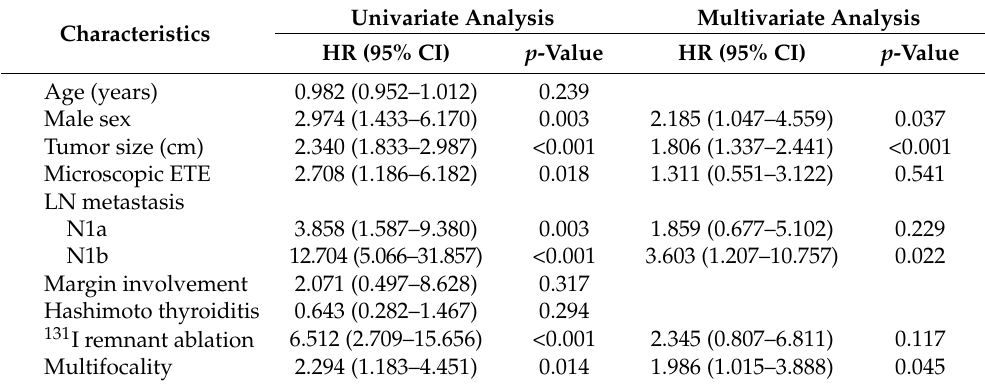
Table 3. Comparison of clinicopathological characteristics between patients with multifocal PTCs and those with unifocal tumor after propensity score